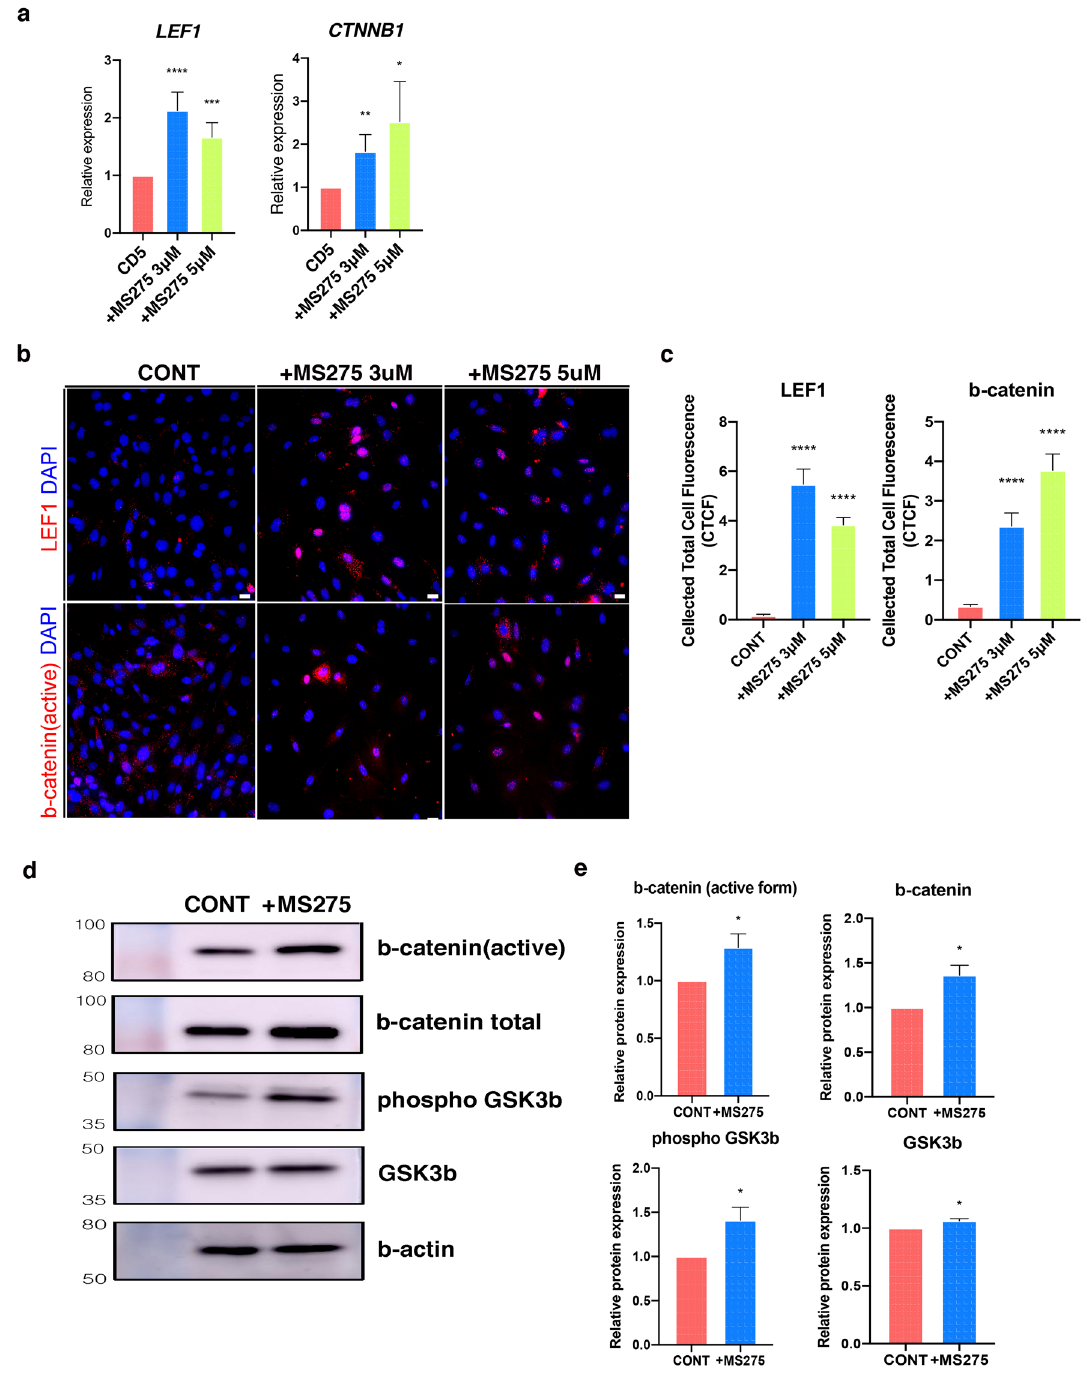
Figure 4. Activated Wnt signaling pathway by the inhibition of class I HDACs. ( a ) Gene expression of Wnt transcription factor LEF1 and CTNNB1 in MS275 treated DCs. Data are shown as the mean ± S.E.M and evaluated by t-test (*, P < 0.05; **, P < 0.01; ***, P < 0.001; ****, P < 0.0001). ( b ) Immunostaining against LEF1 and active β-catenin in MS275 treated DCs. Scale bar, 10 μm. ( c ) Corrected Total Cell Fluorescence (CTCF) graphs of CONT and MS275 treated DCs. The fluorescent intensity from the confocal image of each DCs was determined by ImageJ software. Data were shown as means ± S.E.M in each group. (n = 50) (****, P < 0.0001 vs CONT). ( d ) Immunoblots against β-catenin and GSK-3β from the Wnt signaling pathway in the total protein of MS275 treated DCs. ( e ) The protein expression level shown in (d) were quantified. Data were represented as the mean ± S.E.M. (n = 3) (*, P < 0.05). CONT, controls; DCs, dermal